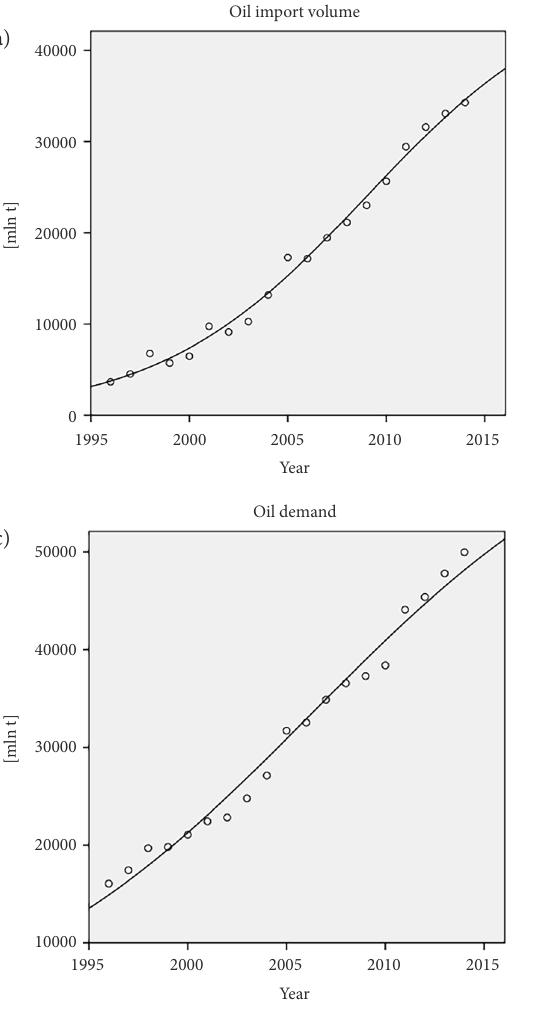
Figure 2. OIGC and OCGC based on LM